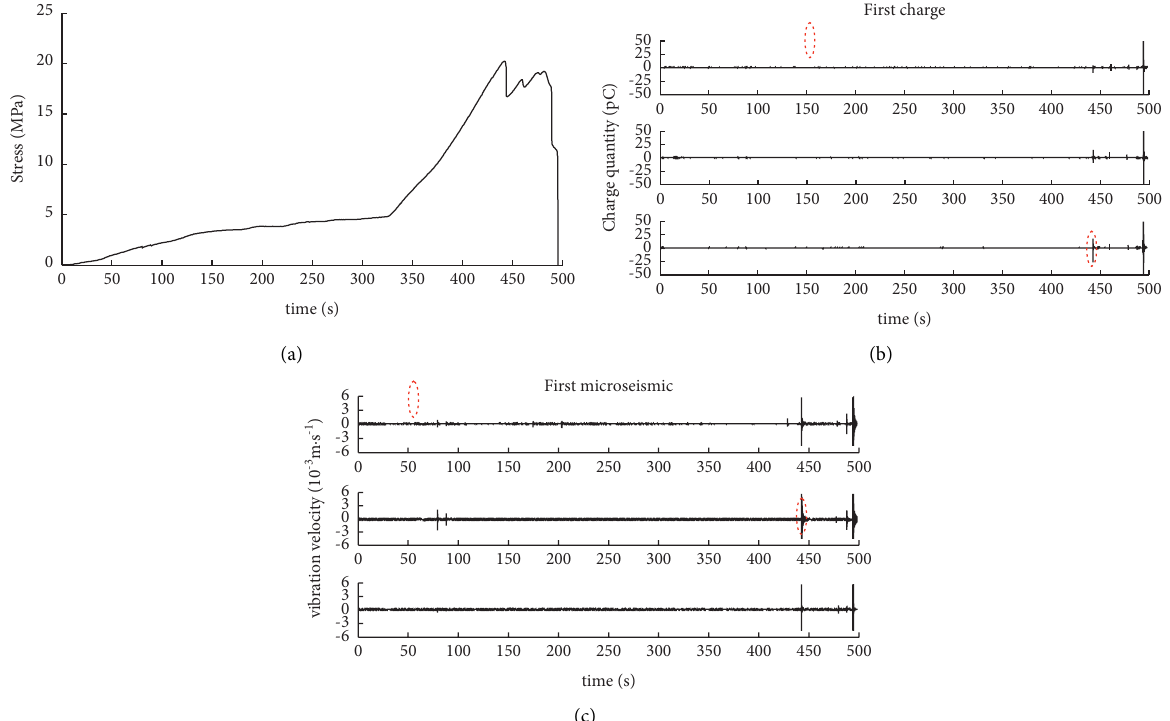
Figure 4: Charge induction and microseismic signals of sandstone when loading rate is 0.005mm/s. (a) Stress curves. (b) Charge induction signals curves. (c) Microseismic signals curves.